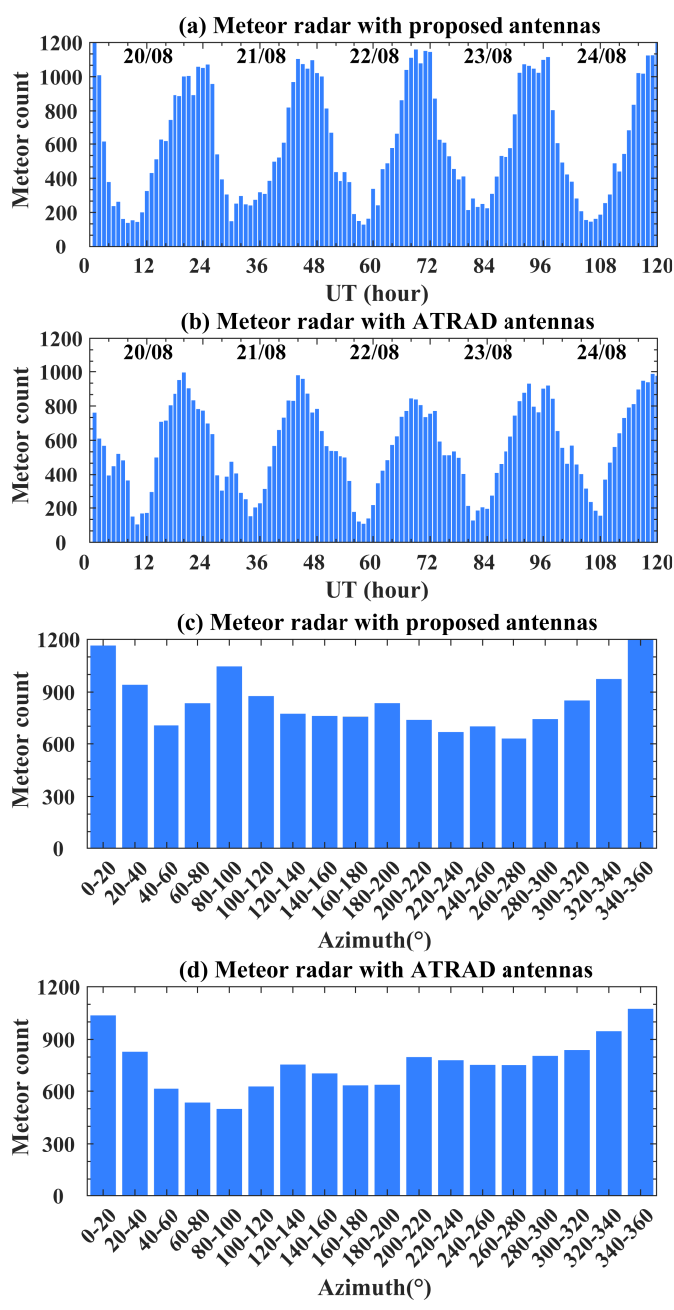
Figure 12. Comparison of count and azimuth distribution of meteors. Meteor radar with antennas of Chinese Meridian Project ( a , c ) and proposed and improved ( b , d ). Table 4. Statics table of meteor quantity with improved